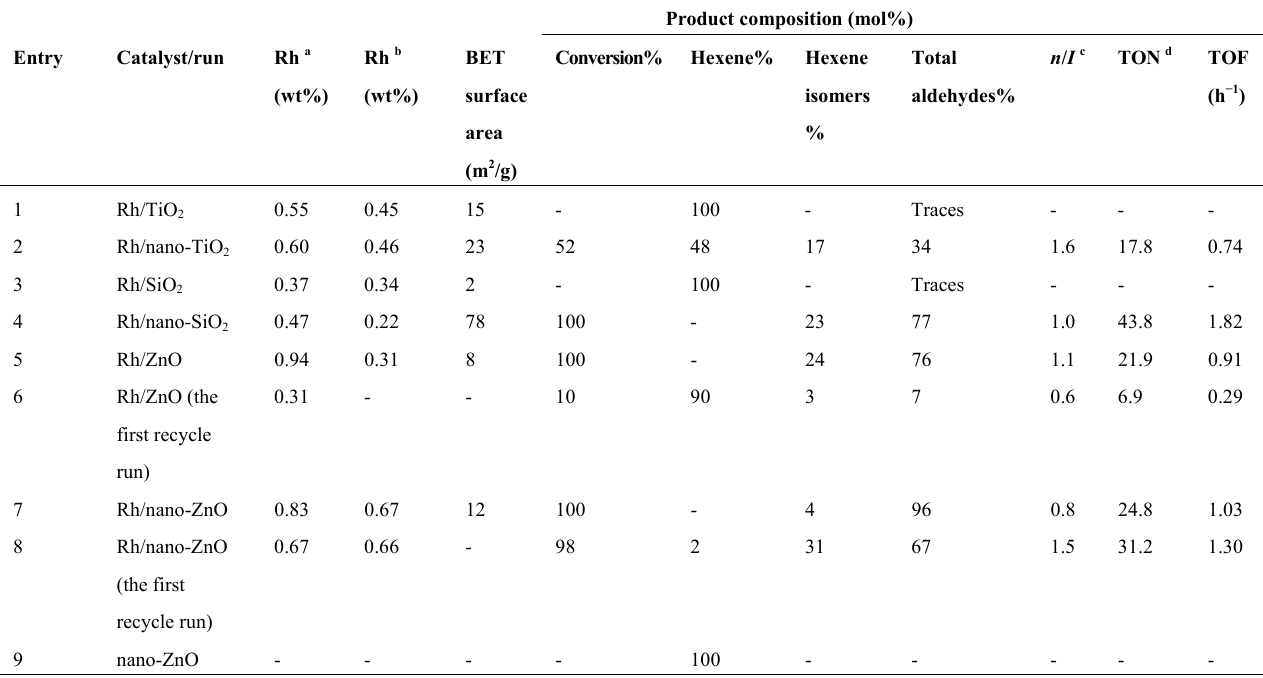
Table 1. Activity of the Rh/nano-oxide catalysts in hydroformylation of 1-hexene. Product composition